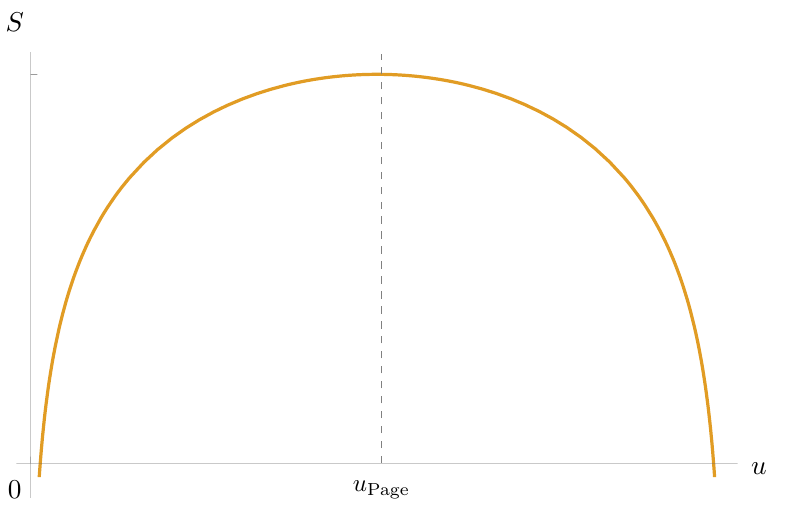
Figure 5 . The radiation entropy collected at I + . For this plot, we took the cut-off (cid:15) = 2 ‘e − 2 GS dS , and ‘ = G = 1 , which fixes c = 3 . The qualitative behaviour is the same for any c ; this just 2 determines the range of u